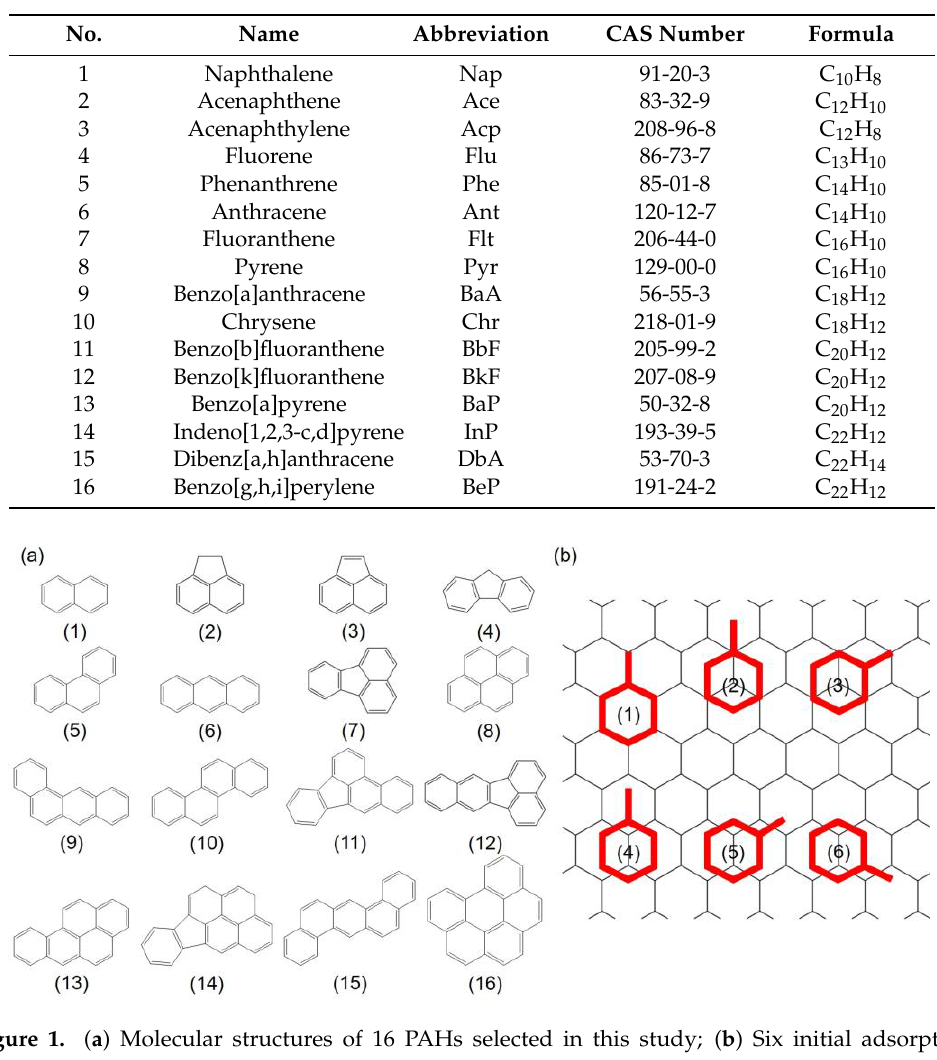
Figure 1. ( a ) Molecular structures of 16 PAHs selected in this study; ( b ) Six initial adsorption configurations of PAHs onto Gr depend on the symmetry of the PAHs: (1) refers to “hollow” site, (2) and (3) are “top” sites, and (4) to (6) indicate “bridge” sites, respectively. Gr is shown as a line model to increase the legibility. Red: PAHs molecules; black: Gr.